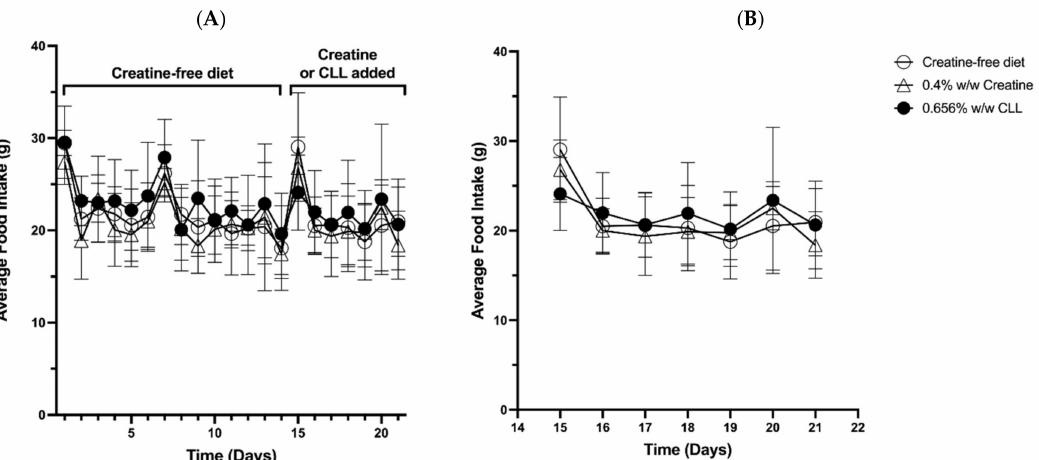
Figure 3. Food intake for all groups. Panel ( A ) Data for all days of experiment and panel ( B ) expanded data for days 15–21. Open circles represent the average daily food intake for rats fed creatine-free AIN-93G diet for the entire 21 days; open triangles represent average daily food intake for rats fed creatine-free diet for 14 days and then switched to AIN-93G diet supplemented with 0.4% ( w / w ) creatine monohydrate for days 15–21; black circles represent average daily food intake for rats fed creatine-free diet for 14 days and then switched to AIN-93G diet supplemented with 0.656% ( w / w ) creatyl- L -leucine (CLL) for days 15–21. Values are presented as the mean ± one standard deviation, n = 8 per